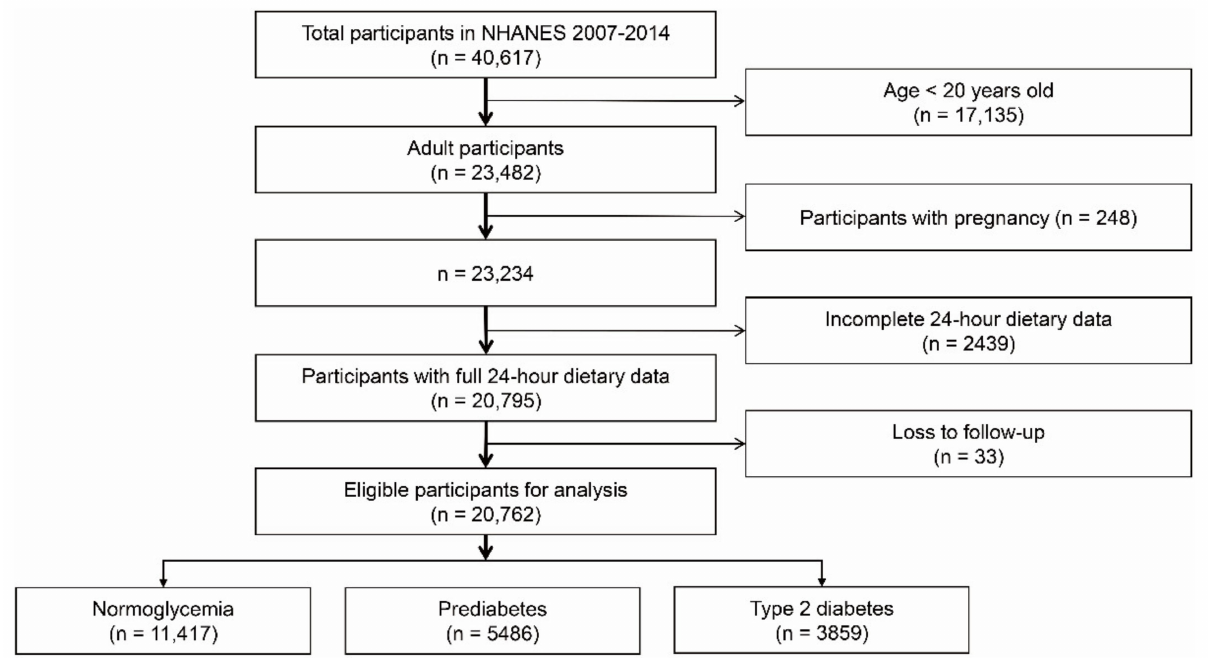
Figure 1. Flowchart of participant selection from NHANES database. NHANES: National Health and Nutrition Examination